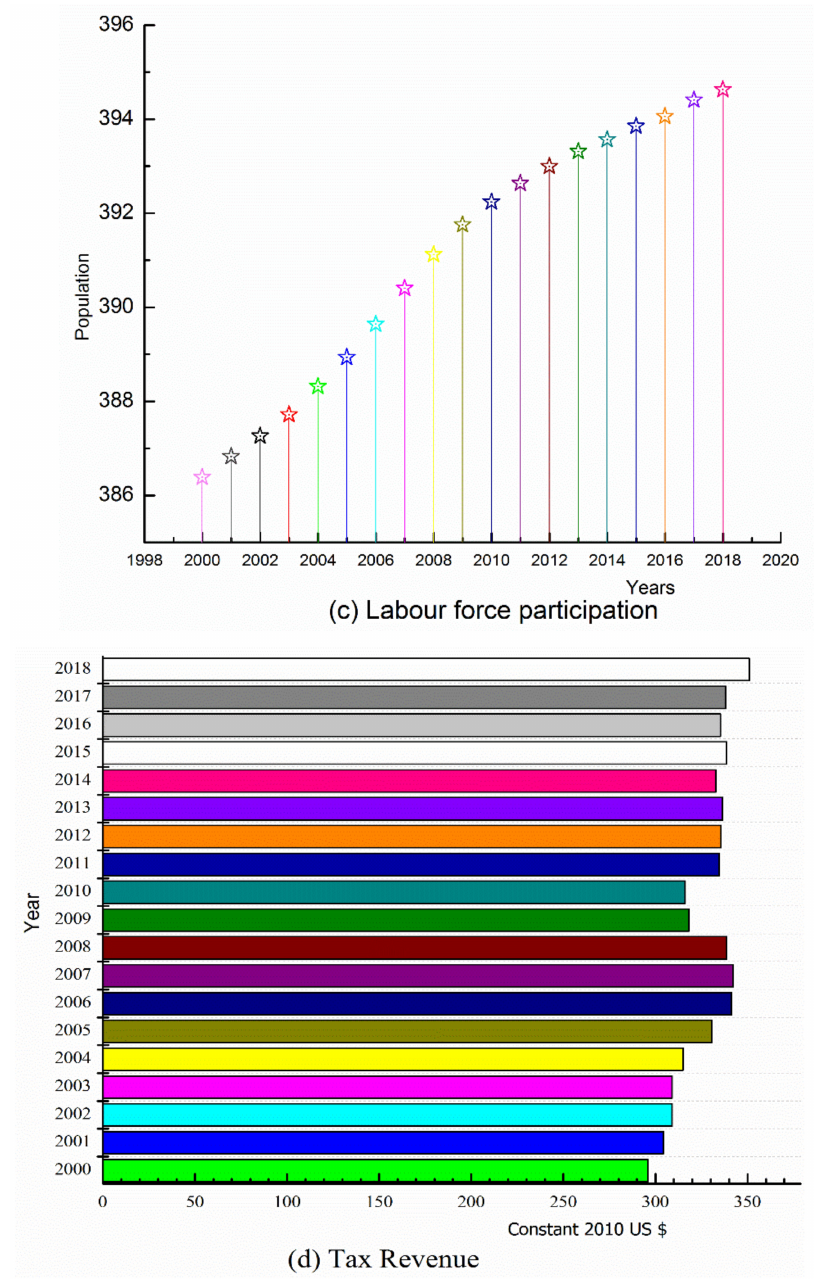
Figure 2. Macroeconomic indicators ( a ) inflation ( b ) GDP per capita ( c ) labor force participation ( d ) tax